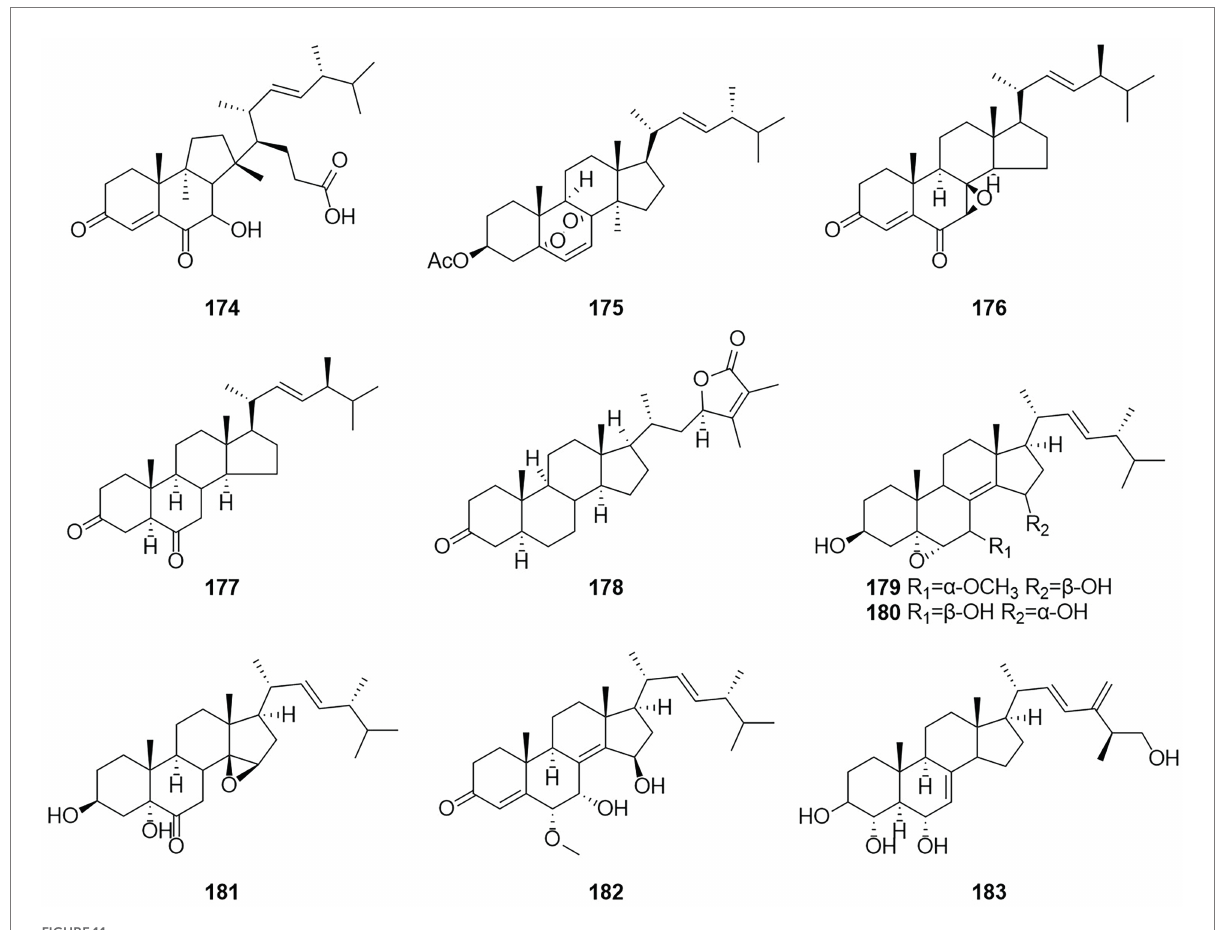
FIGURE 11 Chemical structures of compounds 174–183